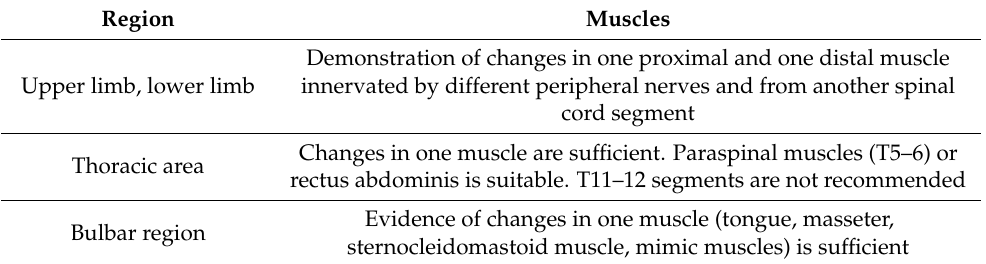
Table 2. Recommended protocol for EMG examination in suspected ALS/MND according to Awaji- Shima [69]. Muscles Demonstration of changes in one proximal and one distal muscle Upper limb, lower limb innervated by different peripheral nerves and from another spinal cord segment Thoracic area Bulbar